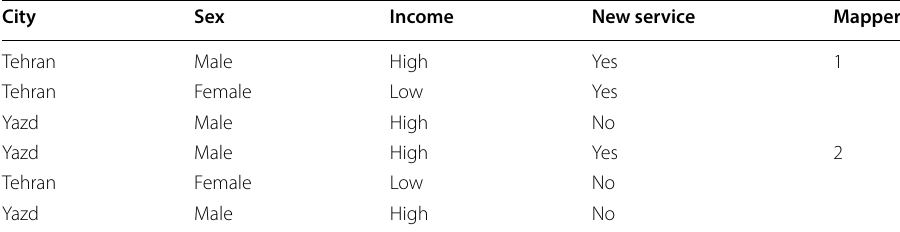
Table 2 Sample input information